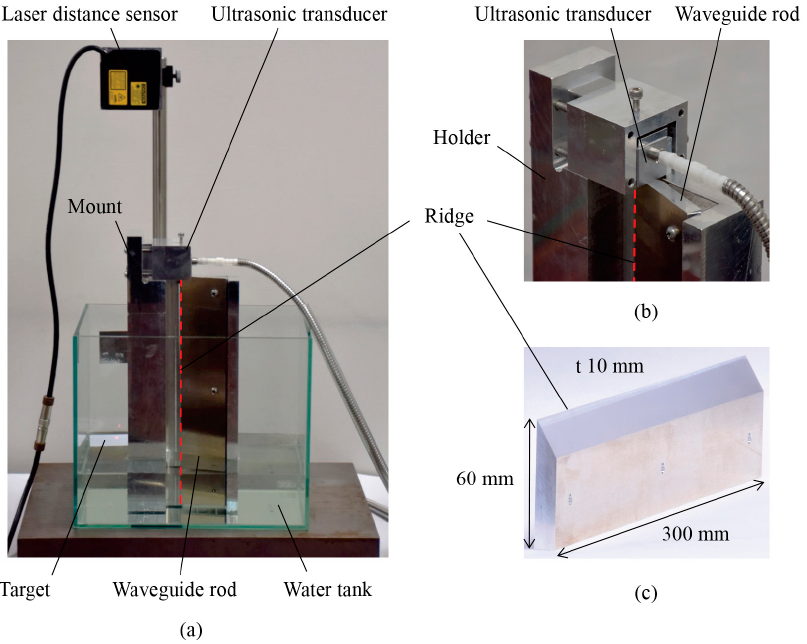
Figure 3. ( a ) Picture of experimental setup for measuring liquid-level. ( b ) Contact part of ultrasonic transducer and waveguide rod. ( c ) Waveguide rod. Red dashed line indicates ridge of waveguide rod.